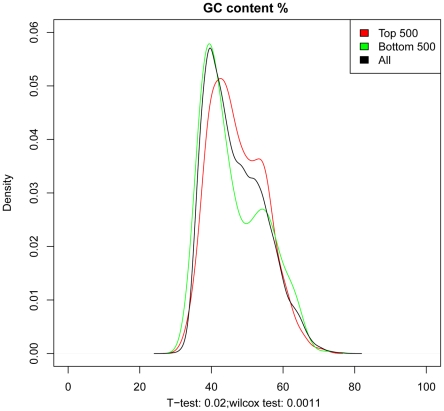
Density distribution of the GC content (%) in the top 500 most highly correlating and bottom 500 least correlating probes.Below the x axis the statistical significance based on the T-test and Wilcoxon signed-rank test is shown. Similar density functions were observed for the top 1000 and bottom 1000 probes.